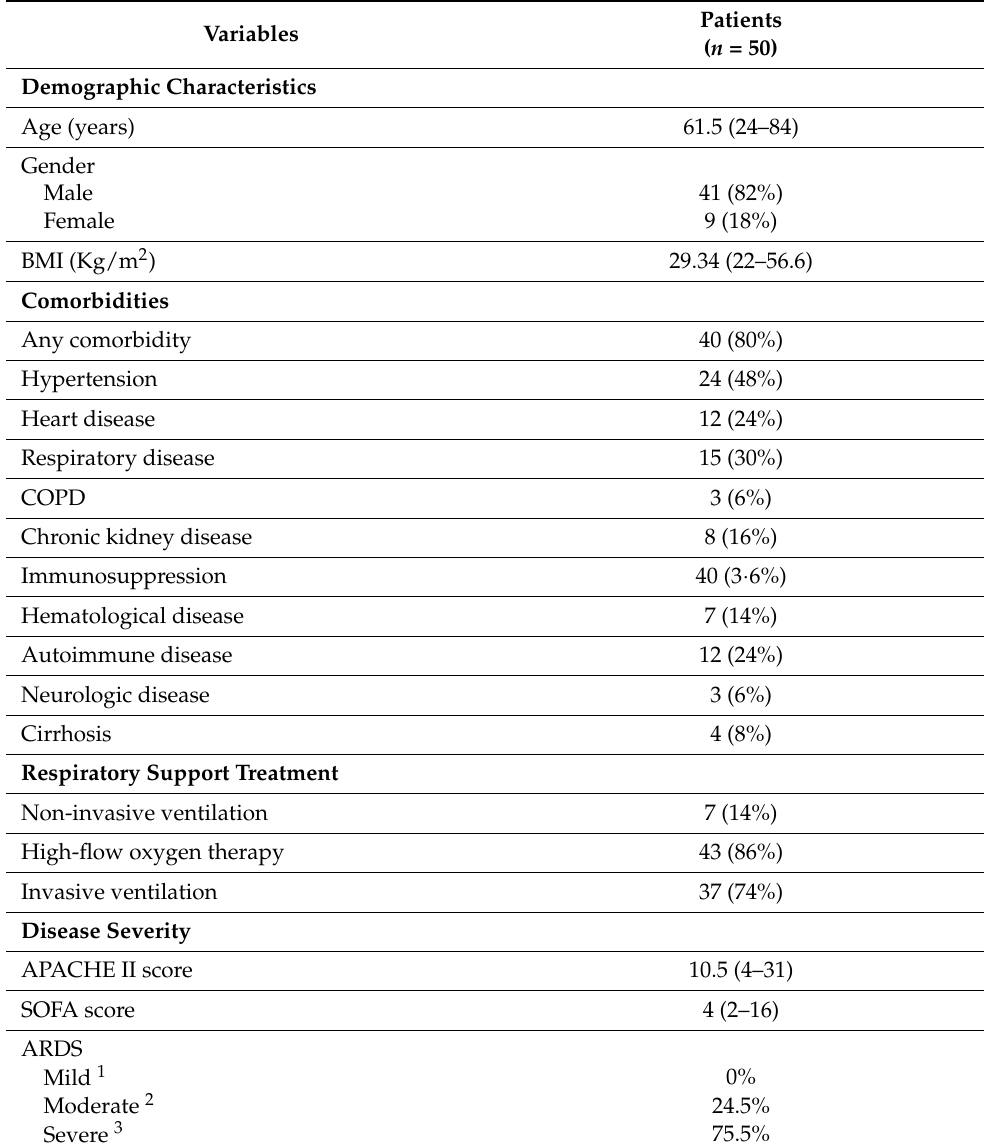
Table 1. Baseline characteristics of patients included in the